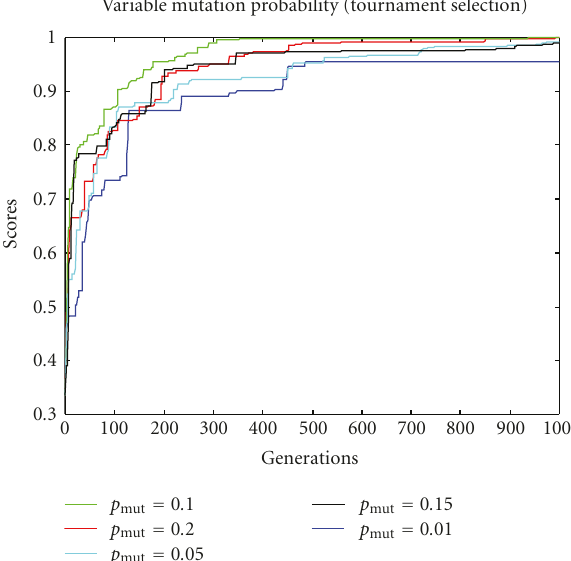
Figure 6: Fitness in various mutation probabilities.